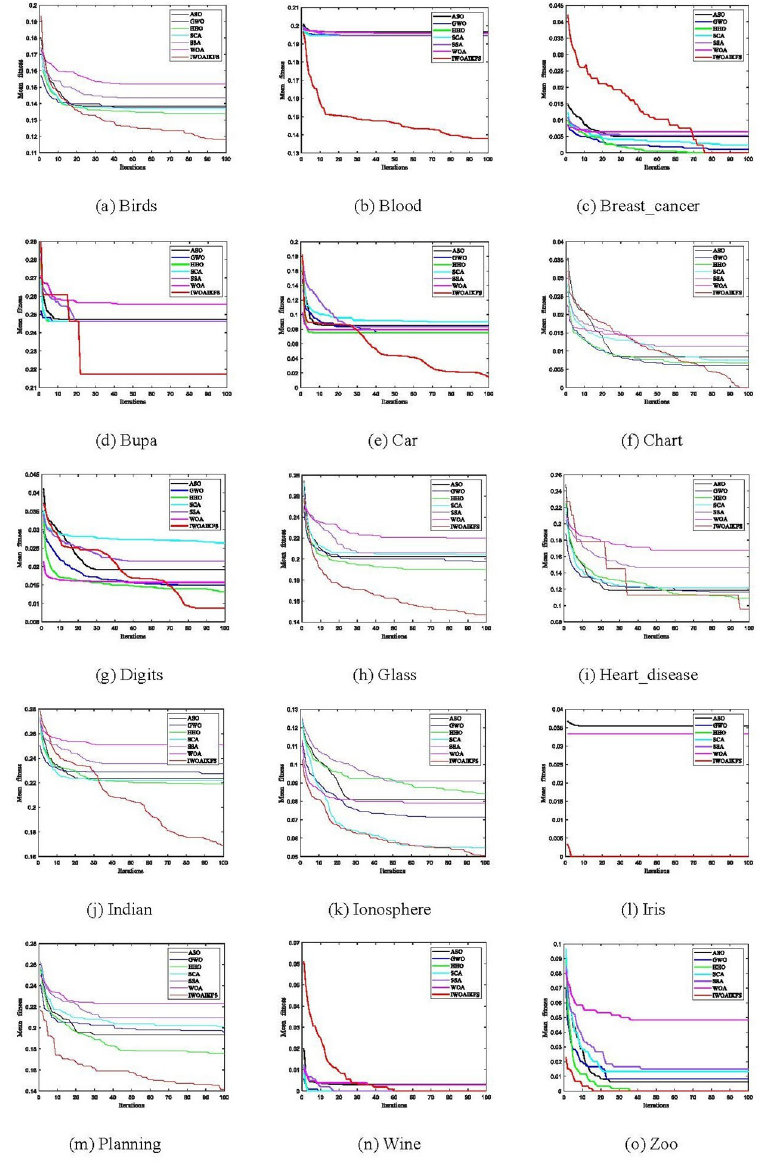
Fig 11. Convergence curve of IWOAIKFS versus other algorithms over all datasets (k = 5). (a) Birds, (b) Blood, (c) Breast_cancer, (d) Bupa, (e) Car, (f) Chart, (g) Digits, (h) Glass, (i) Heart_disease, (j) Indian, (k) Ionosphere, (l) Iris, (m) Planning, (n) Wine, (o)